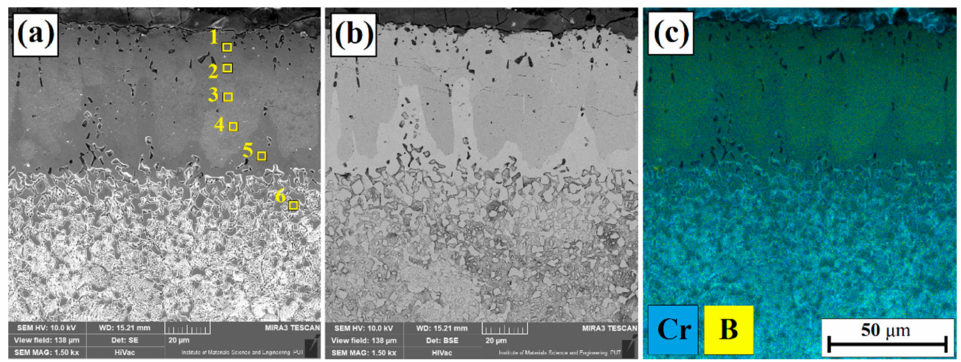
Figure 2. Microstructure of diffusion borochromized layer: ( a ) SE image, ( b ) BSE image, and ( c ) EDS mapping.